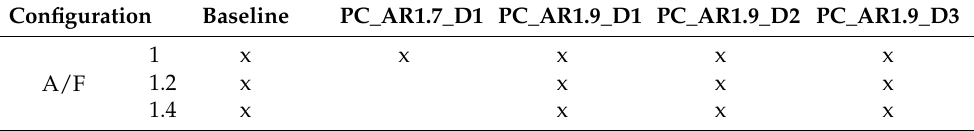
Table 5. Numerical test plan.